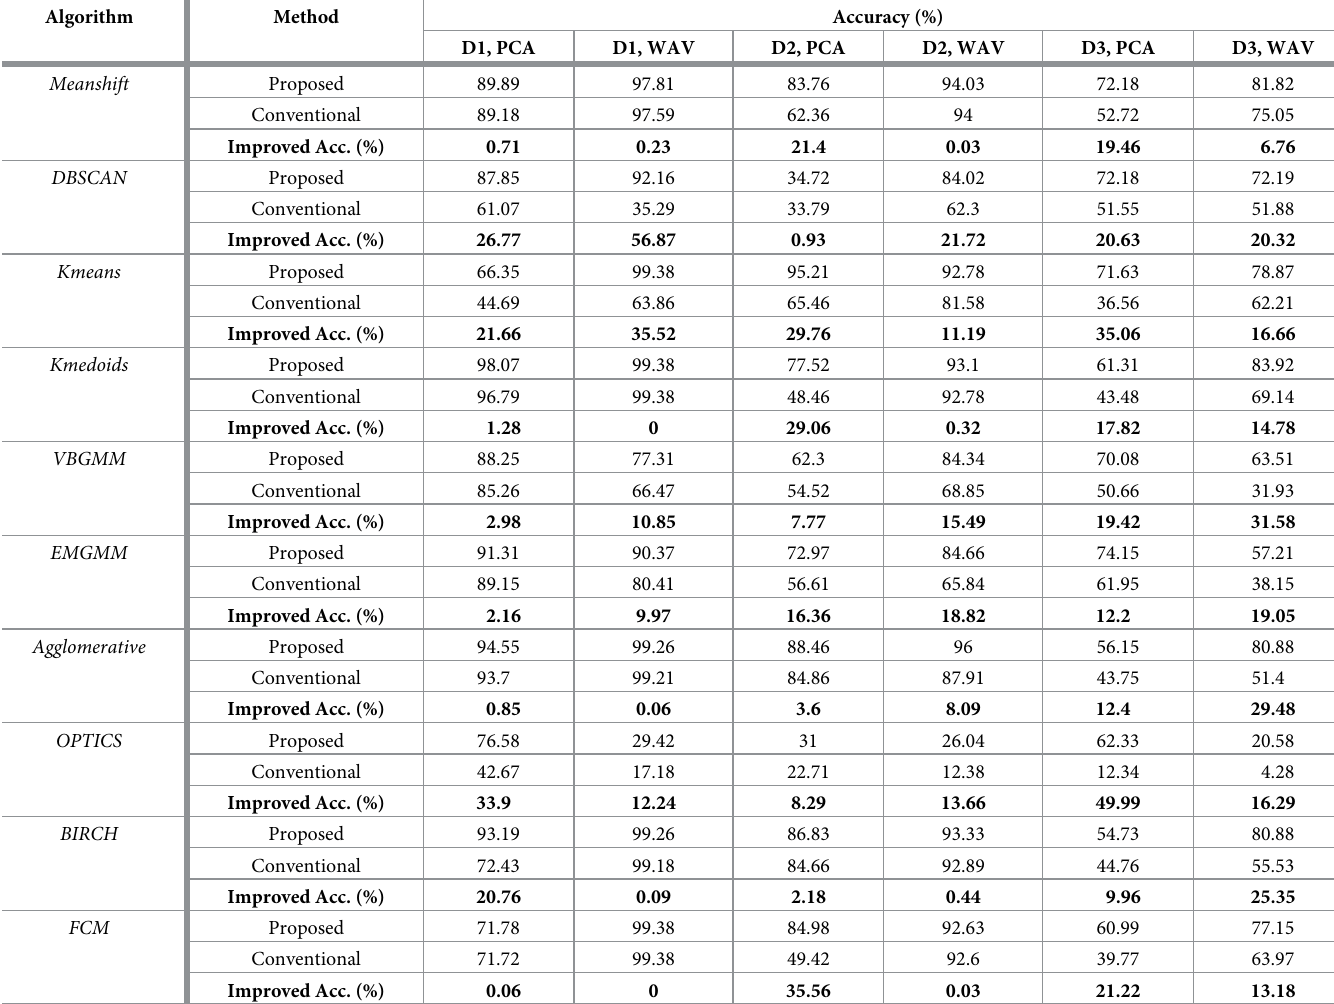
Table 3. Clustering accuracy and accuracy based performance improvement for ten clustering algorithms.